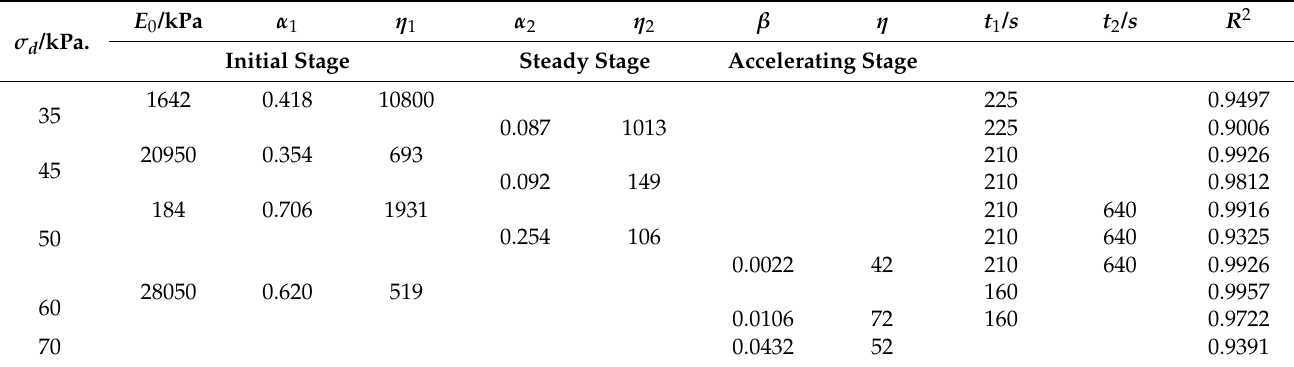
Table 2. Parameters determined via fitting analysis based on the dynamic triaxial test of